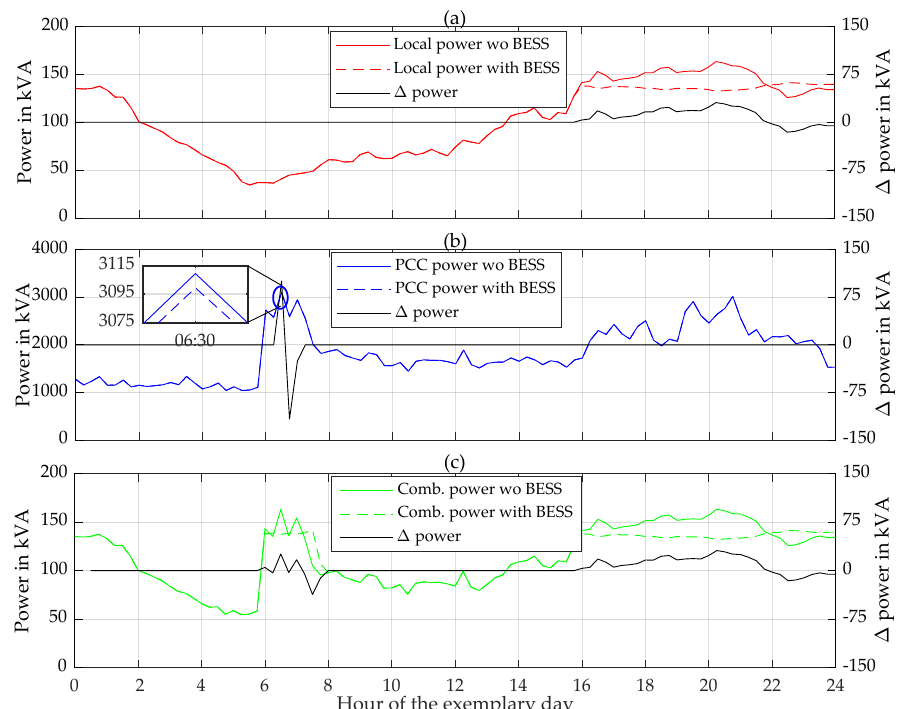
Figure 4. Graphical representation of all three energy management strategies used in this study. Subplot ( a ) shows an exemplary load profile for an industrial consumer at a specific node b. The related power at the point of common coupling is displayed in subplot ( b ) and subplot ( c ) shows the combined profile. The solid line marks the results of the power flow analysis without the battery energy storage system (BESS) at a specific node b and the dashed line marks the results of the power flow analysis including the BESS. The black solid line associated to the right y-axis shows the difference in power, covered by the